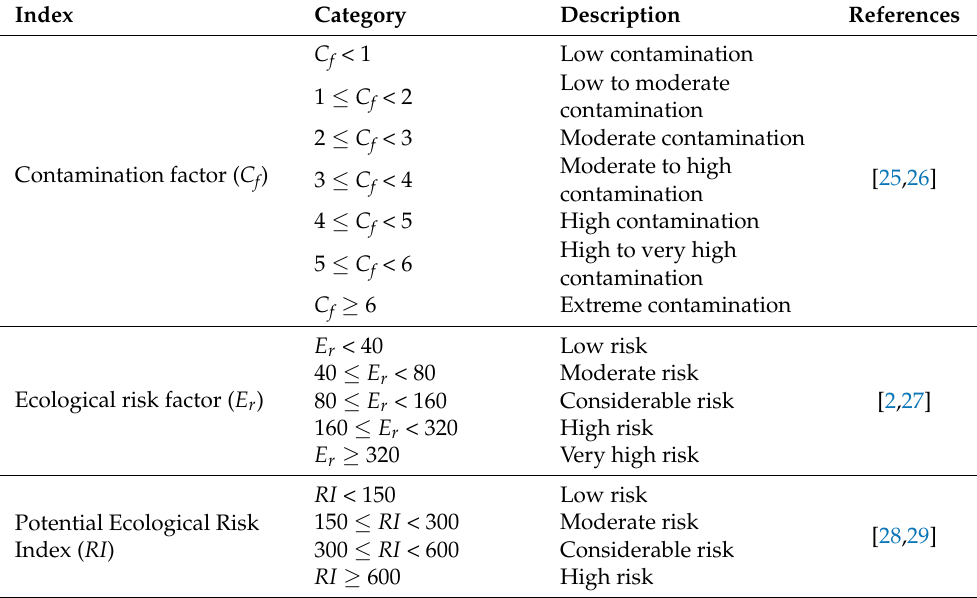
Table 1. Contamination indices classification for soil.